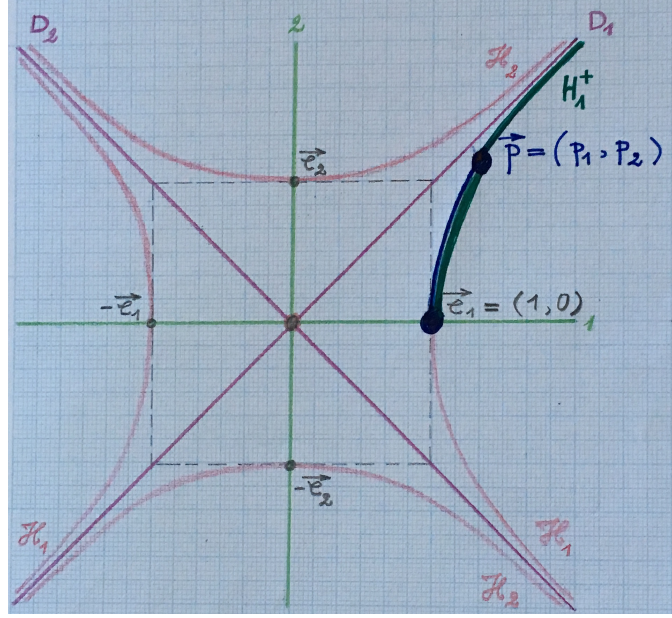
Figure 7. Arclengths on the unit